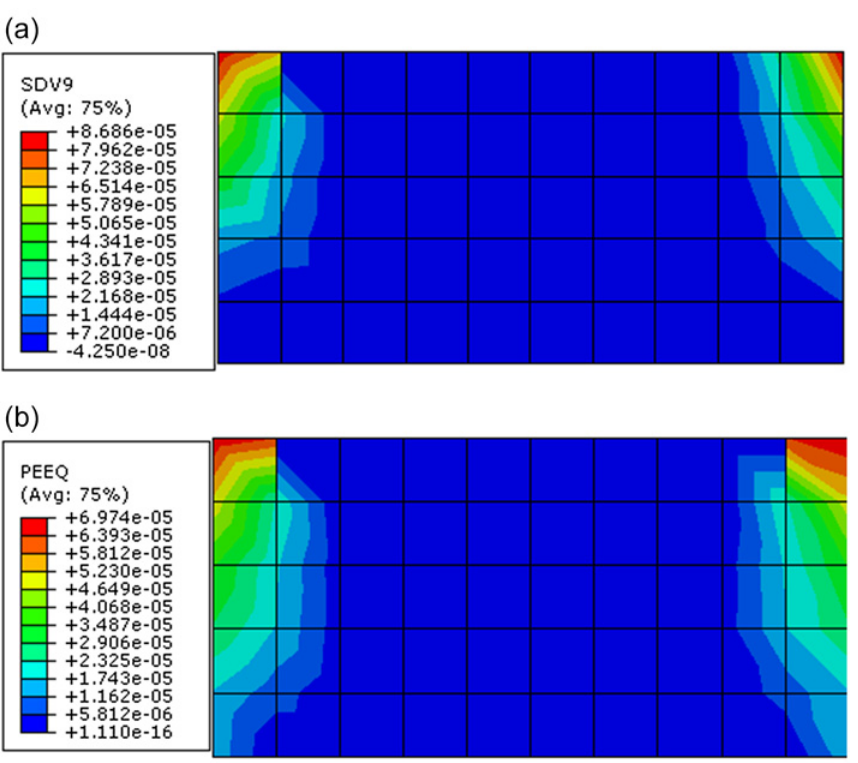
Fig 19. The contour for equivalent plastic deviator strain of the rectangle beam calculated by different constitutive models((a) The contour for equivalent plastic deviator strain calculated by proposed constitutive model;(b) The contour for equivalent plastic deviator strain calculated by ubiquitous- joint model)